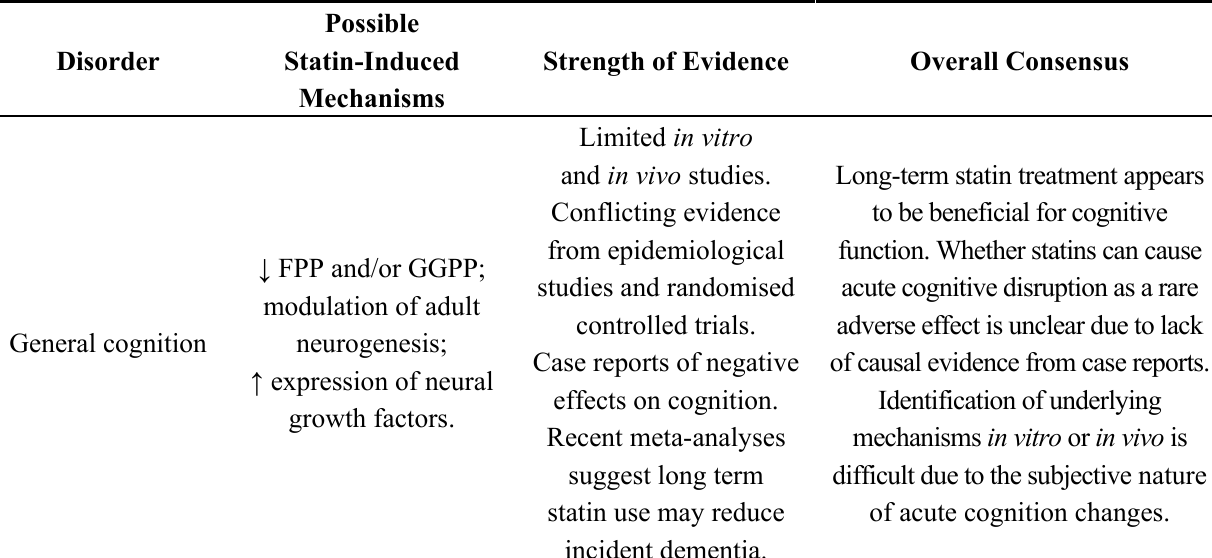
Table 2. Summary of statins’ effects on cognition and neurocognitive